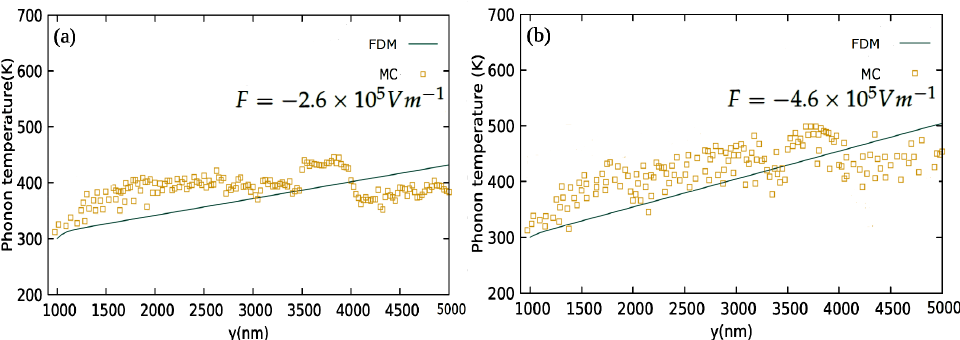
Figure 3. Phonon temperature ( T ph ) along the y direction using the MC and two step model (FDM) for uniform electric fields ( a ) (cid:126) F = − 2.6 × 10 5 Vm − 1 ˆ y and ( b ) (cid:126) F = − 4.6 × 10 5 Vm − 1 ˆ y